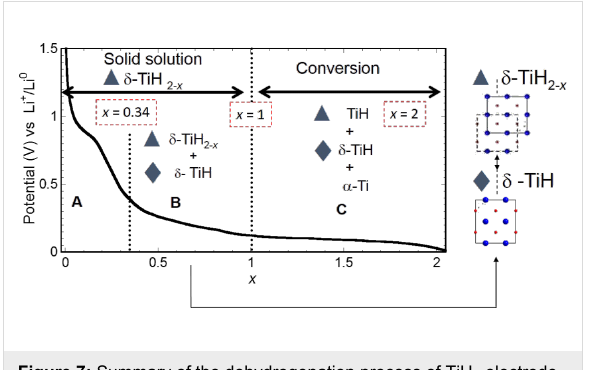
Figure 7: Summary of the dehydrogenation process of TiH 2 electrode δ -TiH 2 − x (fcc): black triangles, TiH (fco): black diamonds, projection along the b -axis of δ -TiH 2 − x (fcc): black triangles and TiH (fco): black diamonds showing the relationship between fcc (black triangles) and fco (black triangles) structures. Adapted from [10] (copyright 2012 Elsevier) and